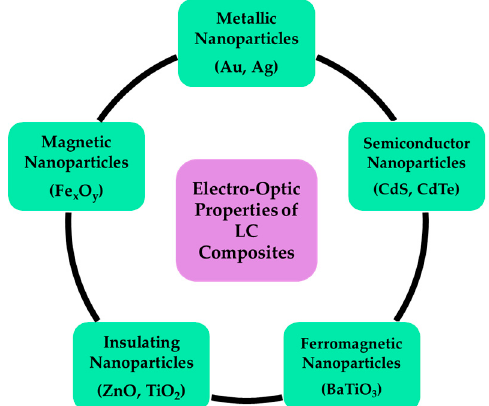
Figure 1. The types of nanoparticles commonly used as a dopant in liquid crystal matrices for altering electro-optical properties.